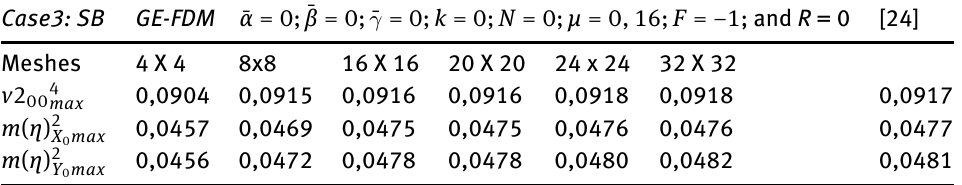
Table 5: Moment and deflection coeflcients for bending combined with unidirectional traction (BCT). Case 4: BCT